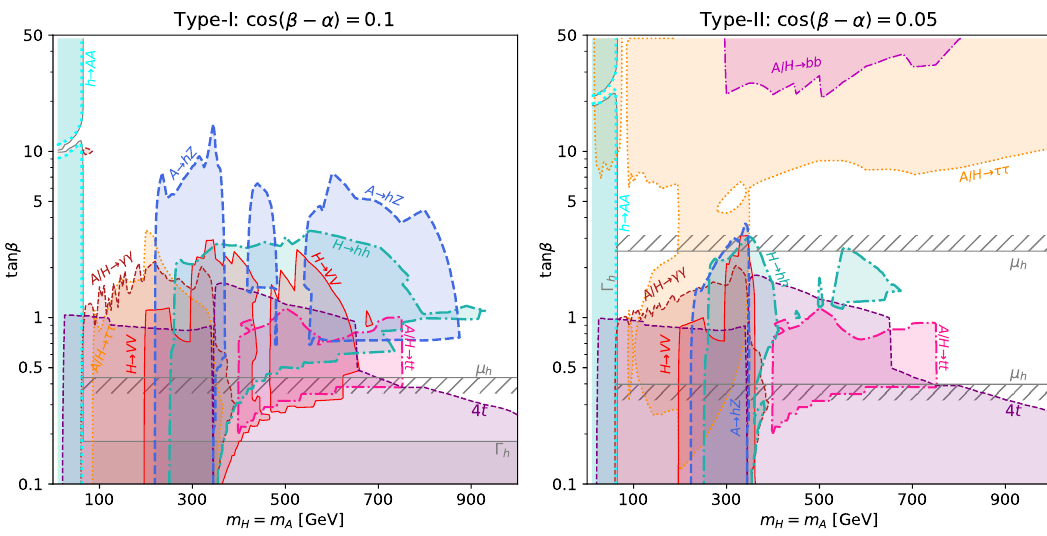
Figure 1 . Constraints for degenerate heavy Higgs mass spectrum m A = m H = m . We show H + the 95% C.L. exclusion region in the m vs. t (cid:12) plane on the Type-I 2HDM with c (cid:12) (cid:0) (cid:11) = 0 : 1 A=H (left) and Type-II 2HDM with c (cid:12) (cid:0) (cid:11) = 0 : 05 (right) originating from i) the measurement of the Higgs width (cid:0) h (grey), ii) the conventional search results on H=A ! (cid:28)(cid:28) (dotted orange), H=A ! bb (dot-dashed pink), H ! V V (red), H=A ! (cid:13)(cid:13) (dashed brown), H=A ! tt (dot-dashed magenta) and 4 t production (dashed purple), and iii) exotic decay channels A ! hZ (dashed dark blue), H ! hh (dot-dashed green) and h ! AA (dotted cyan). Region enclosed by the grey hatched line are excluded at 95% CL. by the current Higgs coupling